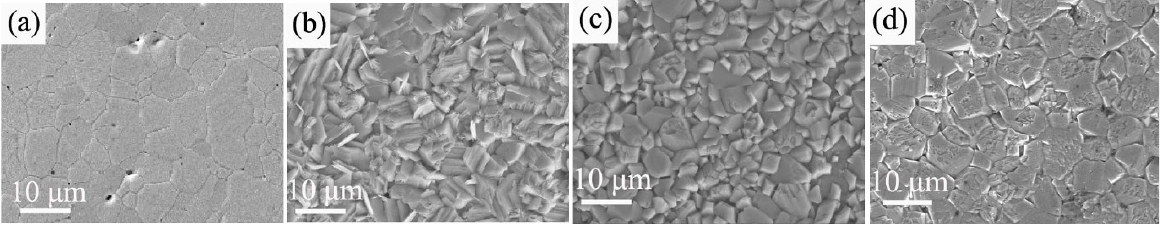
Fig. 7 Surface morphologies of (a) A0, (b) A1, (c) A2, and (d) A3 ceramics after sintering at 1175 ℃ .